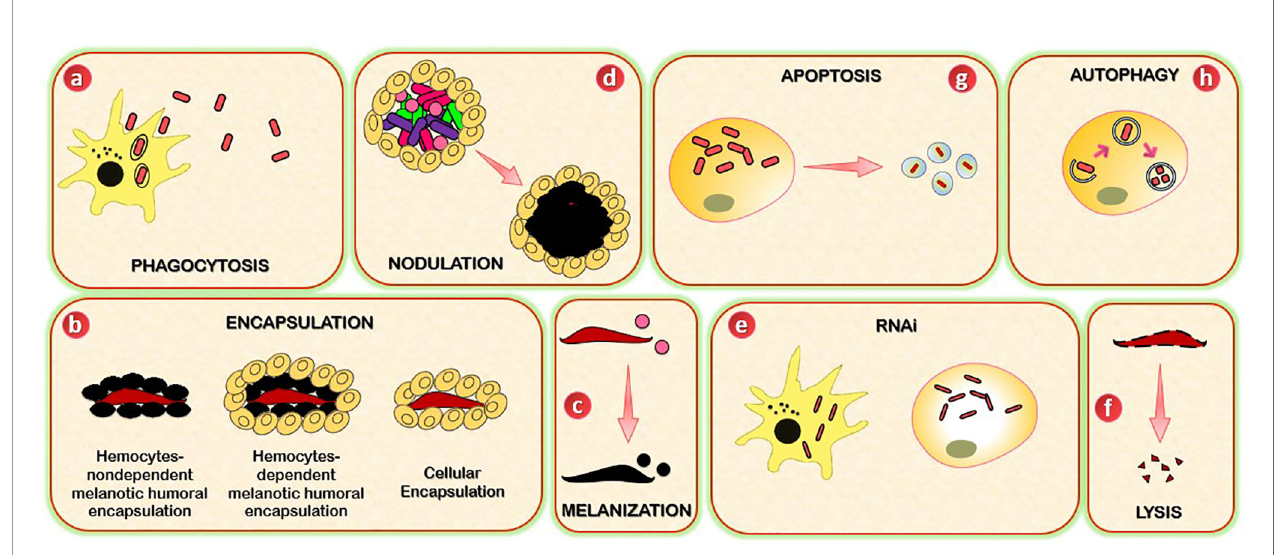
FIGURE 2 | Schematic representation of insects ’ immune effector mechanisms. (A) Insects use phagocytosis to neutralize and kill small pathogens. This process is mediated by phagocytes (hemocytes or granulocytes). (B) Encapsulation (cellular and melanotic) is a defense mechanism that insects used when pathogens are too large to be phagocytosed. Cellular encapsulation occurs without melanization, whereas melanotic humoral encapsulation is dependent on PO activity and can occur with or without the assistance of hemocytes. (C) Melanization is a process based on the conversion of PPO to PO, which leads to the formation of the melanotic capsule (melanotic enzymes) which mediates the killing of the foreign agent. (D) Nodulation is a process by which immune cells (granulocytes) adhere to each other to create layers that surround many bacteria or fungal spores. The granulocytes release their contents, which trap the bacteria in a fl occulent material. This step is often followed by melanization. (E) RNAi mechanism is based on the ribonuclease cleavage of viral dsRNA and is speci fi cally used against viruses, and can be mediated by immune circulating cells (hemocytes, macrophages). (F) Lysis is a mechanism through which insects kill pathogens by disrupting their cellular membrane. The process involves the participation of peptides and proteins with antimicrobial activity, including lysosomes. (G) Autophagy provides protection to insects against pathogens through the degradation of cytoplasmic material (bacteria or viruses). (H) Apoptosis is a programmed cell death mediated by caspases. The killing of pathogens includes the formation of apoptotic